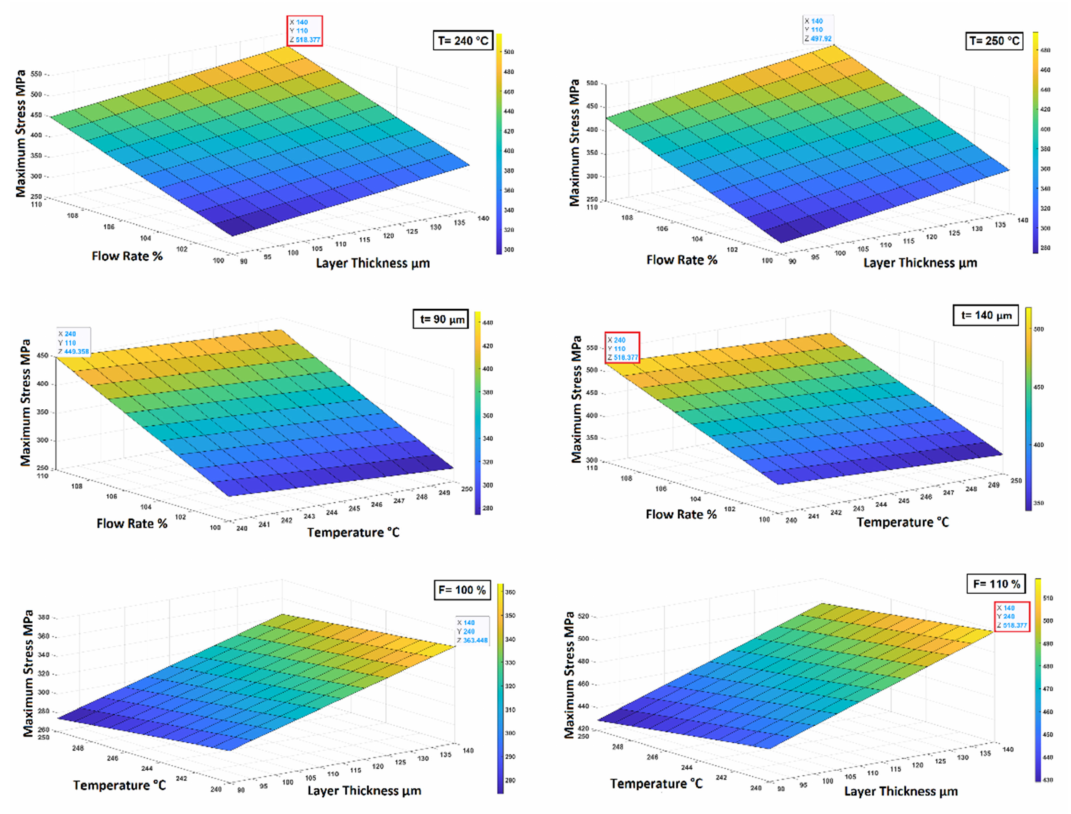
Figure 11. Surface response obtained for tensile strength.